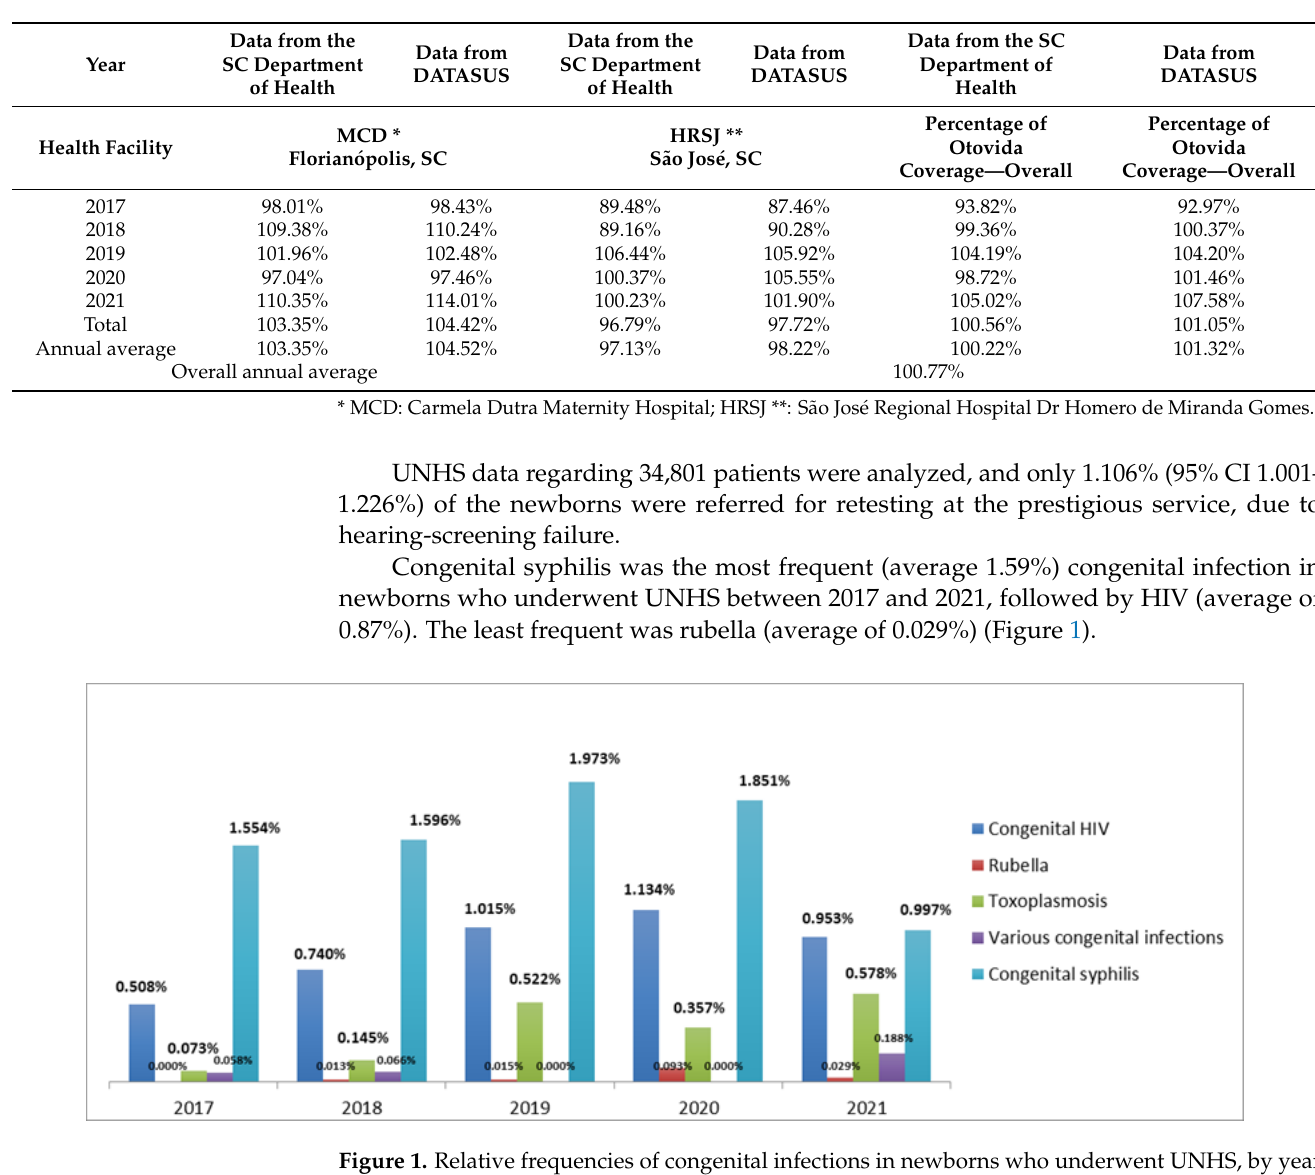
Figure 2. Relative frequencies of RIHL in newborns who underwent UNHS, by year of birth. Floria- nópolis, SC, 2017 to 2021 (n = 34,801). Table 2. Relative frequency of craniofacial anomalies and neurological disorders in newborns in UNHS, by year of birth. Florianópolis, SC, 2017 to 2021 (n = 34,801). Variable Year of Birth